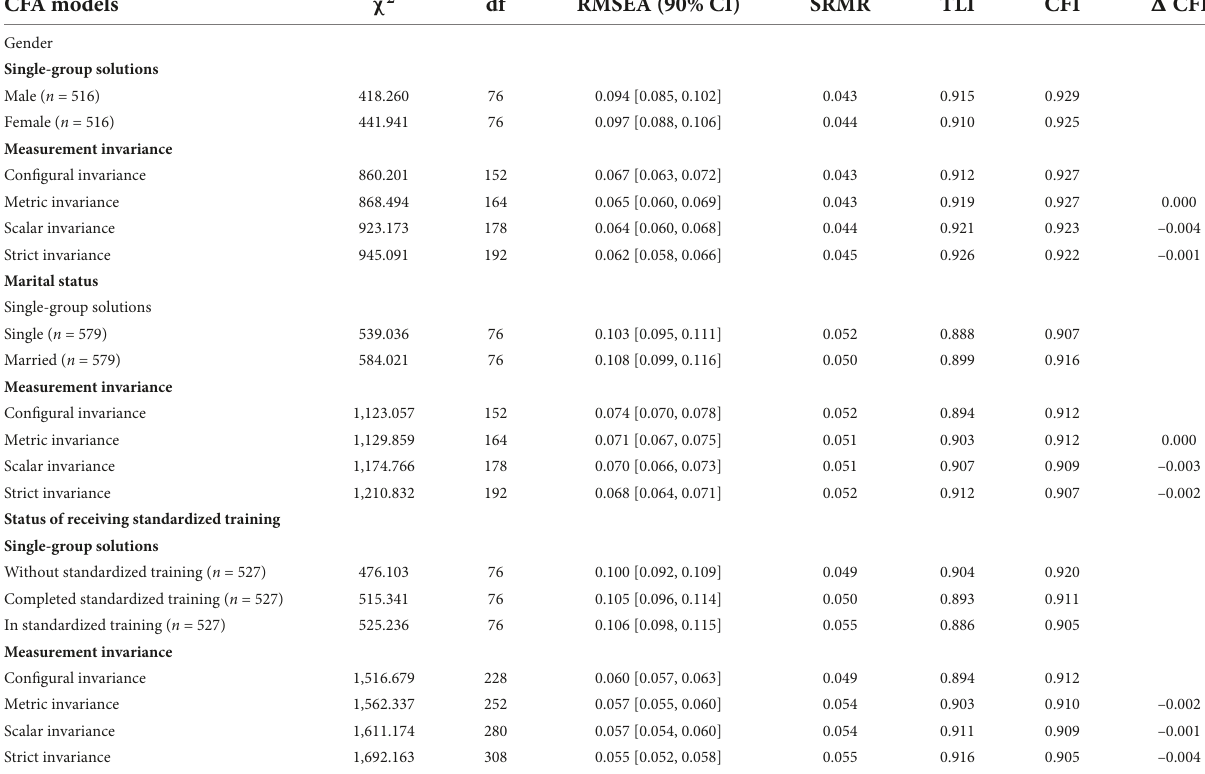
TABLE 2 Tests of measurement invariance of the RS-14 in a population with different demographic